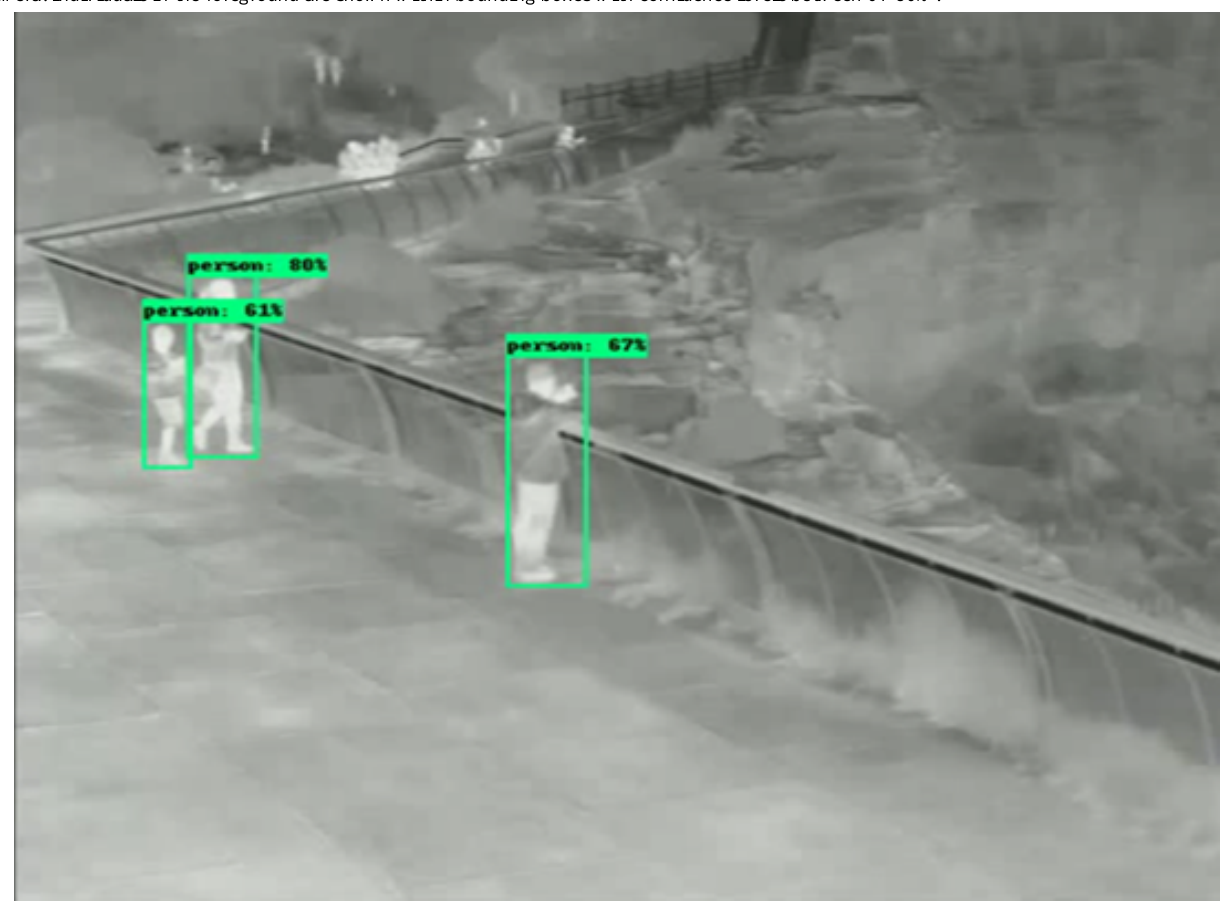
Figure 10. Pedestrian Identification using Thermal Cameras. The output of the EfficientDet pedestrian detection algorithm using data from a thermal camera. Individuals in the foreground are shown within bounding boxes with confidence levels between